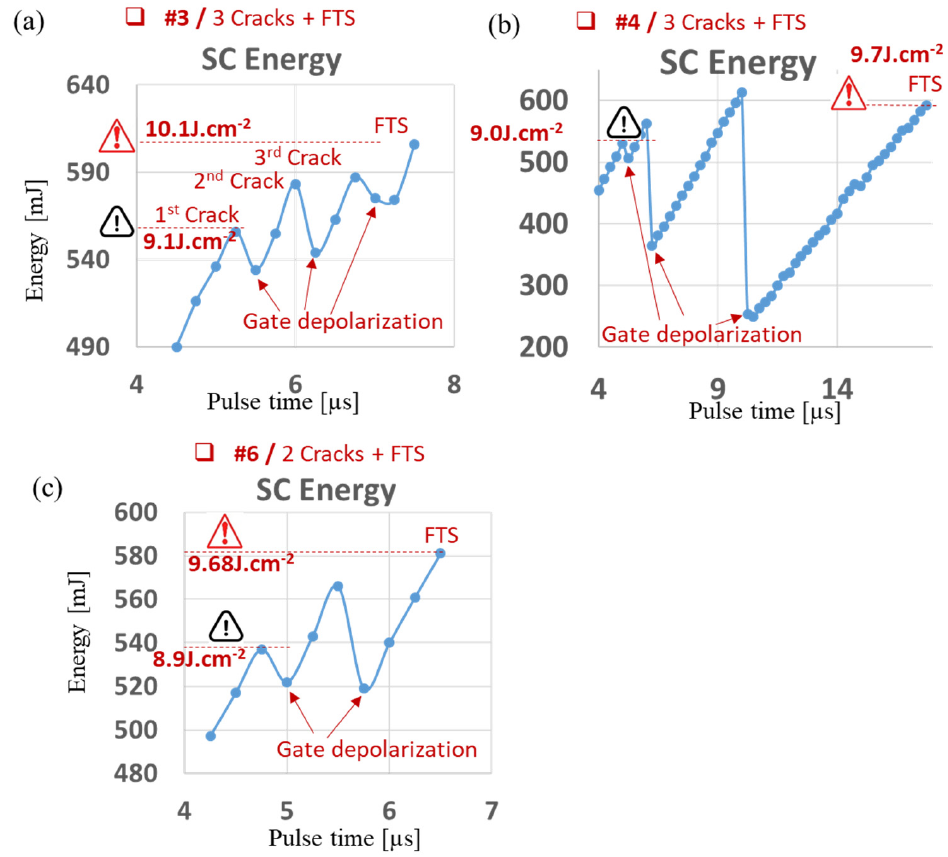
Figure 9. Energy dissipated for each incremental pulse test, exhibiting the failure energy behavior. For all DUT tested the gate-damage occurred between 530 mJ and 550 mJ. On the other hand, the FTS occurred between 581 mJ and 606 mJ. The robustness margin was small between the soft gate-damage and the hard failure mode. This small margin was visible when 110% of the gate-damage pulse was applied on an unstressed device; exhibiting directly an FTS.